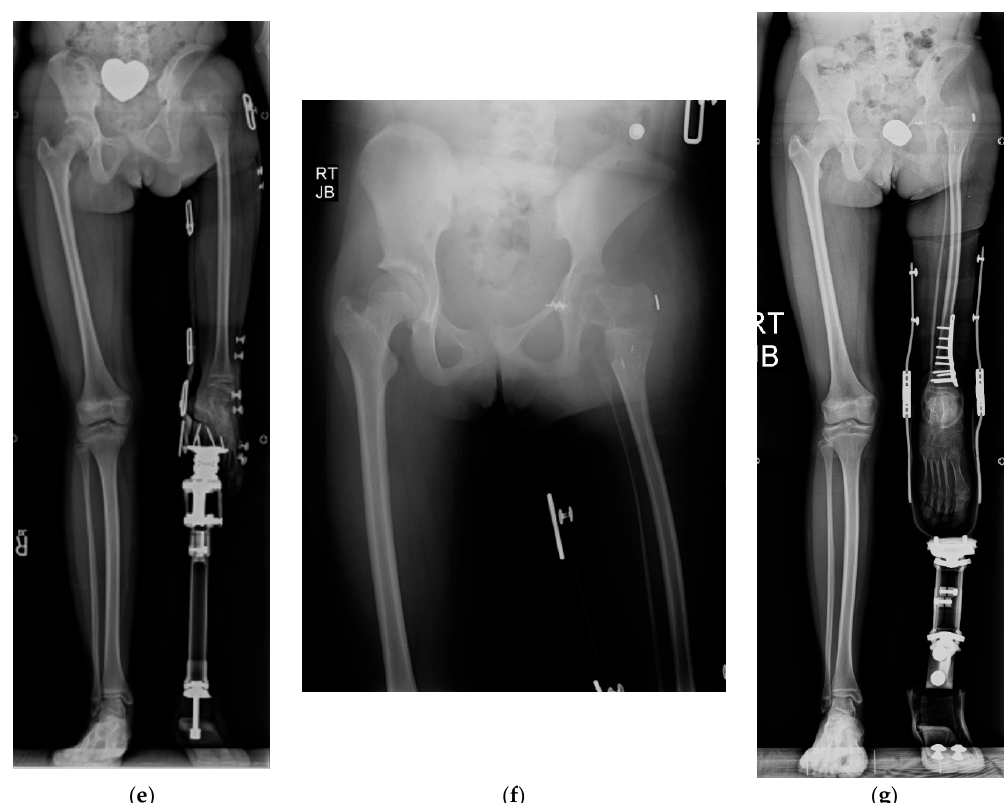
Figure 5. ( a ) Illustration of CFD Paley type 3c. There is an ankylosed knee with a small distal femoral remnant. ( b ) Illustration showing the femoral head is enucleated to make room for the femoral condyle or tibial plateau in the acetabulum. ( c ) Paley–Winkelmann rotationplasty illustration, inserting the femoral condyle remnant into the acetabulum secured with a hip tethering suture. ( d ) AP pelvis radiograph of a 12-year-old girl with CFD Paley type 3c. ( e ) Standing long radiograph of same girl showing the ankle is at the level of the opposite knee. ( f ) AP pelvis radiograph of same girl after Paley–Winkelmann rotationplasty with femoral condyle in the acetabulum. The tethering suture anchor is seen. ( g ) Standing radiograph of same girl 5 years after Paley–Winkelmann rotationplasty. She has excellent function of the new hip joint and can walk and run with very minimal limp.